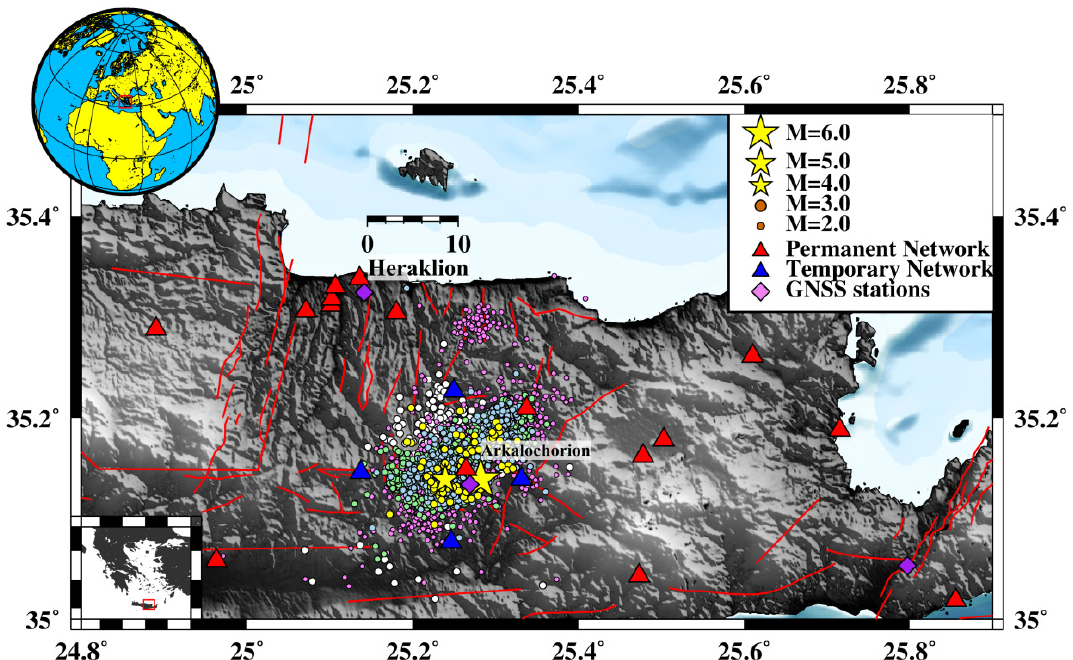
Figure 2. Spatial distribution of the 2021–2022 Arkalochori sequence, for 4750 events that occurred during the period between 13 January 2021 to 31 January 2022. The locations of the permanent (red triangles) and the temporary (blue triangles) stations are presented. The M ≥ 4.0 earthquakes are depicted by yellow stars. Faults are marked as red lines (see text for details). On the top left corner, the location of Greece is indicated in the red triangle while on the bottom left one the study area is included in the red rectangle. Table 1. Comparison of the error statistics between Model 1 [28] and Model 2 [29] for the Arkalochori seismic